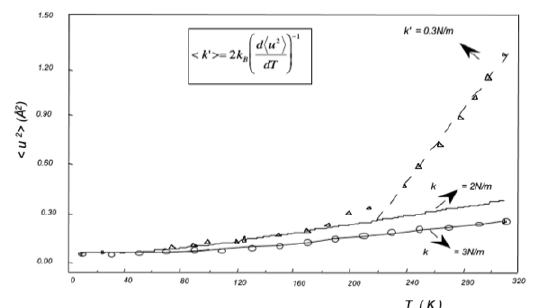
Fig. 2. Elastic window temperature scans on IN13 (8 µeV resolution) at the Institut Laue Langevin (ILL) [15] of myoglobin in a hydrated powder (triangles) from [12], and in a trehalose glass (circles) from [14].